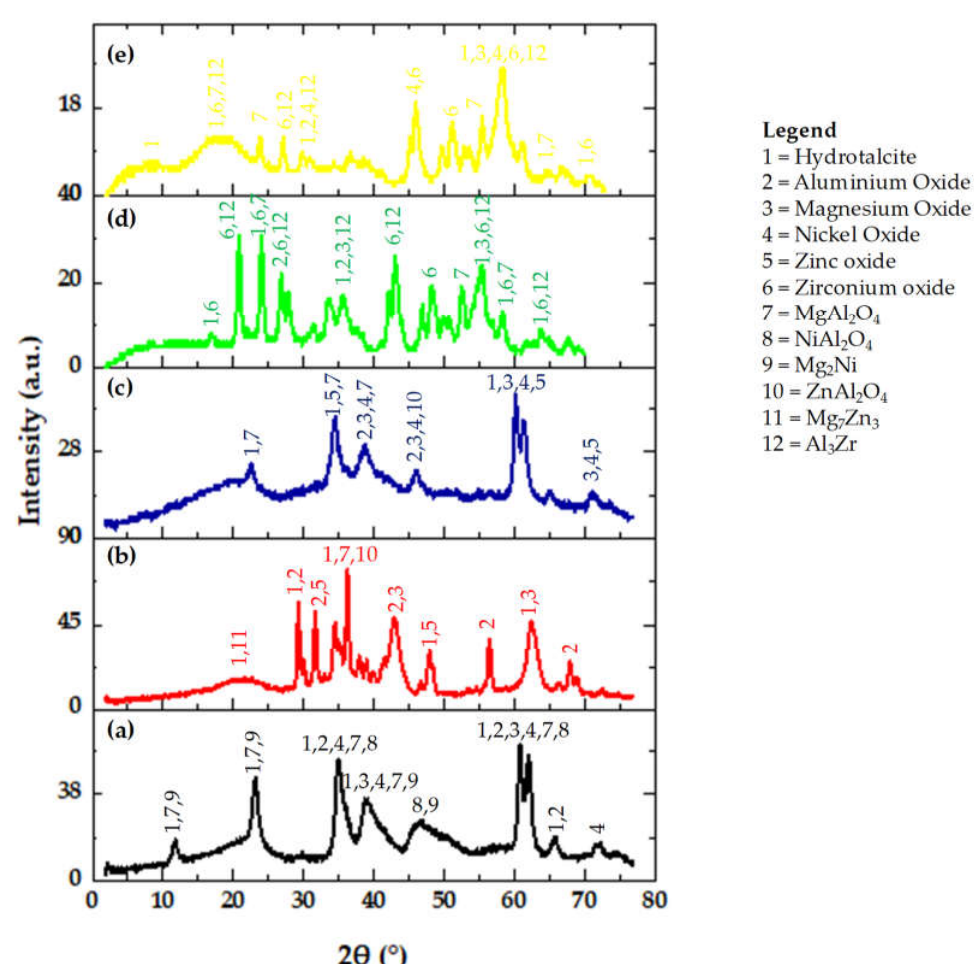
Figure 2. XRD analysis of calcined ( a ) Ni adsorbent; ( b ) Zn adsorbent ( c ) Ni and Zn adsorbent, ( d ) Zr adsorbent ( e ) Zr and Ni adsorbent (legends indicated on top of the peaks correspond to the various crystalline and amorphous phases identified from JCPDS file no. 14-0191).